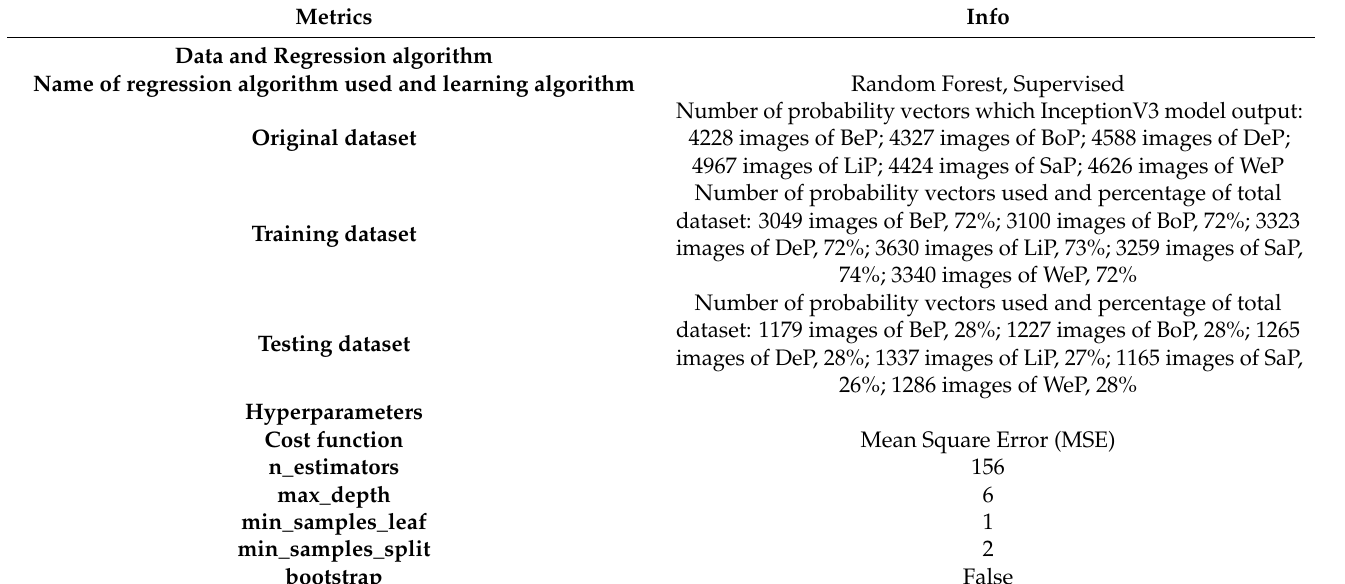
Table 3. Reporting the regression algorithm of this study